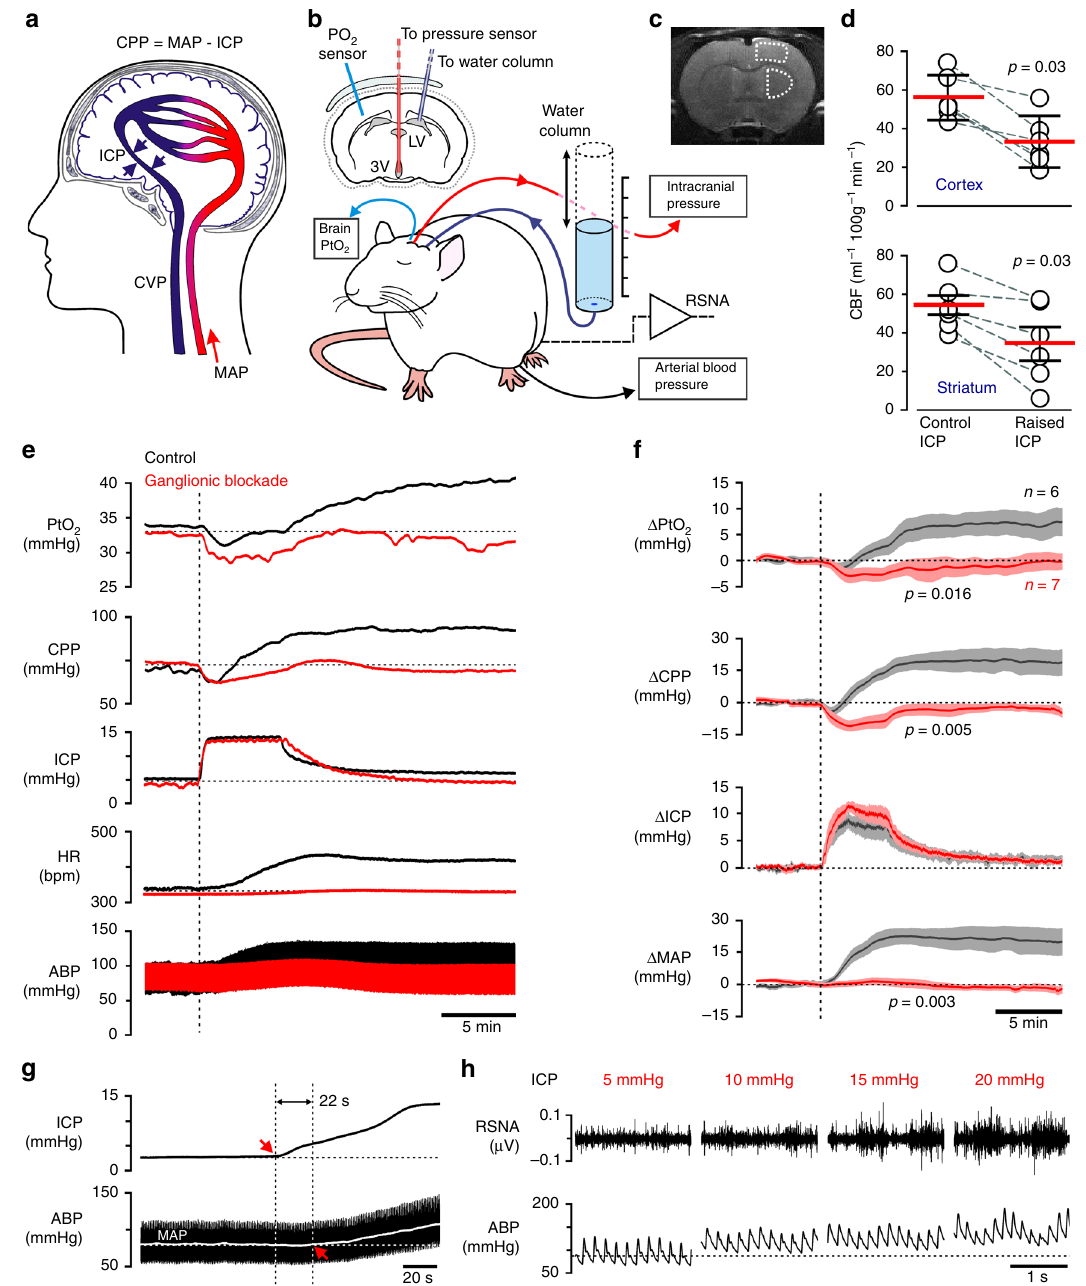
Fig. 1 Control of systemic circulation by an intracranial baroreceptor. a Brain blood fl ow is driven by cerebral perfusion pressure (CPP) which is determined by the difference between the mean arterial blood pressure (MAP) and intracranial pressure (ICP). CVP, central venous pressure. b Diagram of the experimental setup in anesthetized rats instrumented for the recordings of cortical tissue partial pressure of oxygen (PtO 2 ), ICP (via a cannula implanted into the 3rd cerebral ventricle, 3V), systemic arterial blood pressure and renal sympathetic nerve activity (RSNA). CPP was acutely decreased by raising ICP using a water column connected via a saline- fi lled mini-catheter to a cannula placed in the lateral cerebral ventricle (LV). c High resolution magnetic resonance scan of the rat brain with regions of interest outlined and d summary data illustrating values of cerebral blood fl ow (CBF) at resting conditions and in conditions when ICP was raised by 10 – 15 mmHg. Individual values and means ± SEM are shown. p -values, Wilcoxon signed-rank test. e Representative raw traces and f summary data (means ± SEM) illustrating changes in cortical PtO 2 , CPP (calculated), ICP, heart rate (HR) and arterial blood pressure (ABP) induced by an experimental manoeuvre to increase ICP by ~10 mmHg in control conditions and under systemic ganglionic blockade with chlorisondamine. p -values, ANOVA. g Representative recording (expanded) illustrating a short delay between the onset of ICP increase and the resultant blood pressure response. h Representative recordings of RSNA and ABP responses to graded increases in ICP. Source data are provided as a Source Data fi